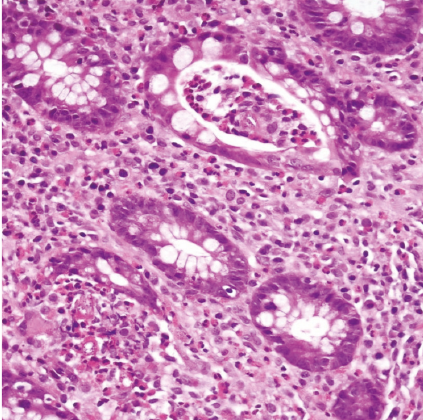
Figure 4: Eosinophilic microabscesses within glands and lympho- plasmacytic infiltrate in the lamina propria. H&E 20x.